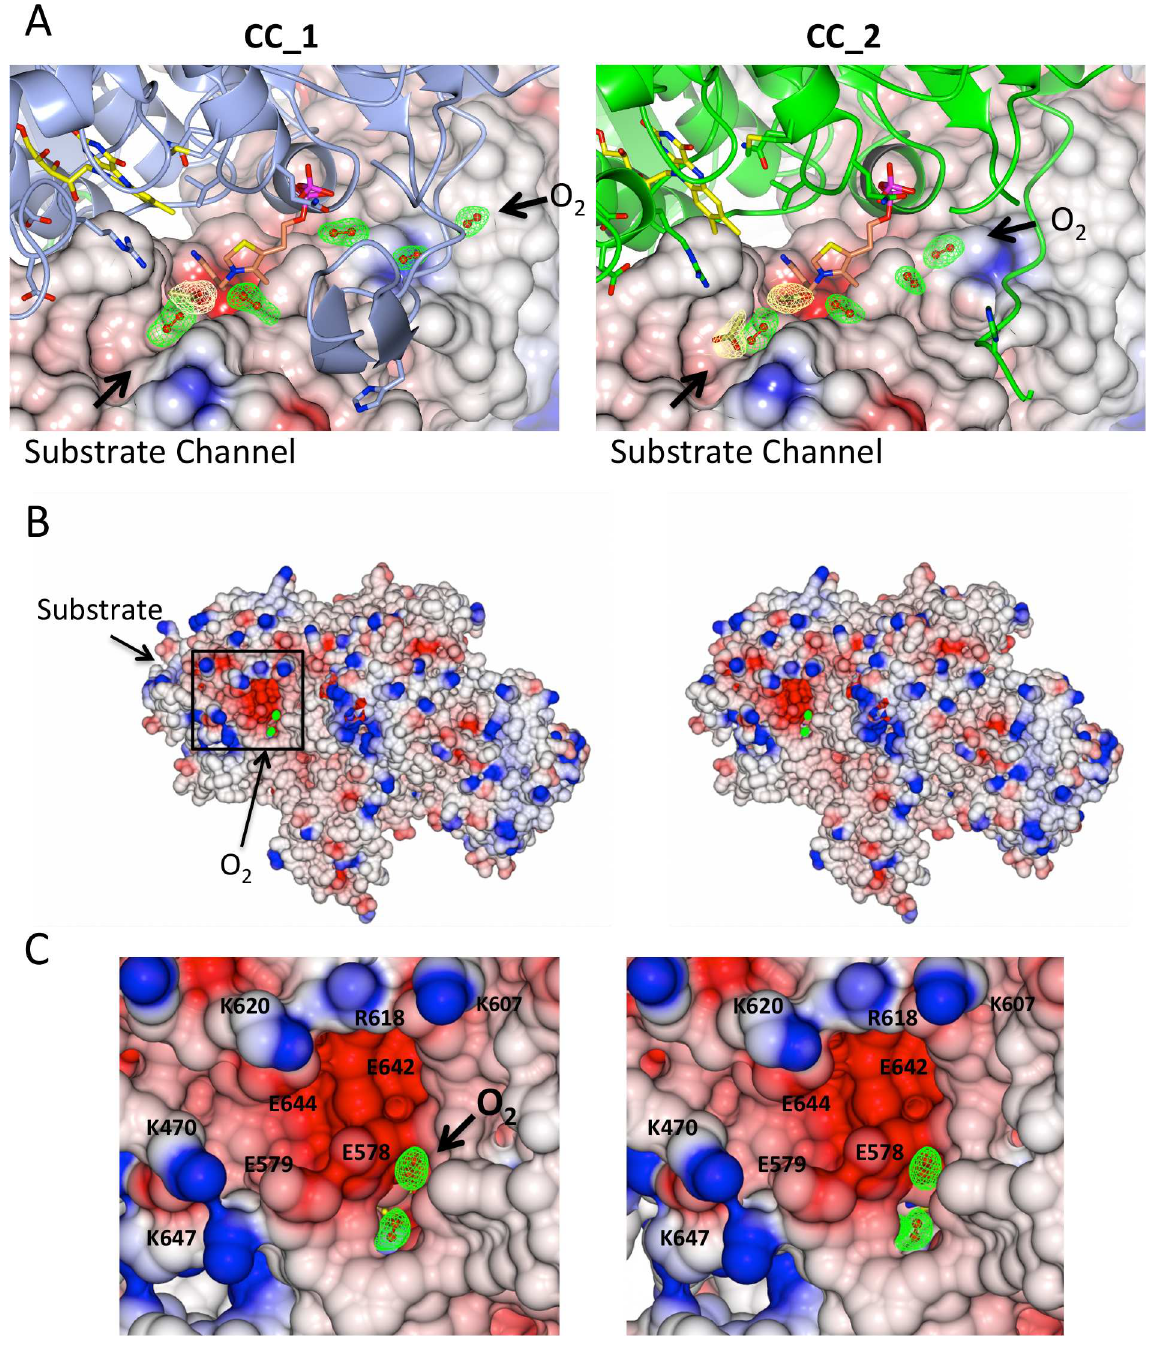
Fig 6. Stereo views of Sc AHAS showing that substrate and O 2 accessthe active site by different routes. (A) Overviews of CC_1 and CC_2 showingthat substrate and O 2 have different routes to access the active site. (B) Electrostatic potentialsurface of Sc AHAS. (C) inset of (B) focusingon the entry of the O 2 tunnelthat connects the solvent exposedsurface to the active site. (A) to (C) Green electron density contoured at 3.5 σ in a F o —F c map for the O 2 molecules.(A) Lemon electrondensities(2F o − F c ) correspond to acetate moleculescontoured at 1.5 σ (acetate closest to ThDP in CC_1 and CC_2) and 1.2 σ (secondacetate in